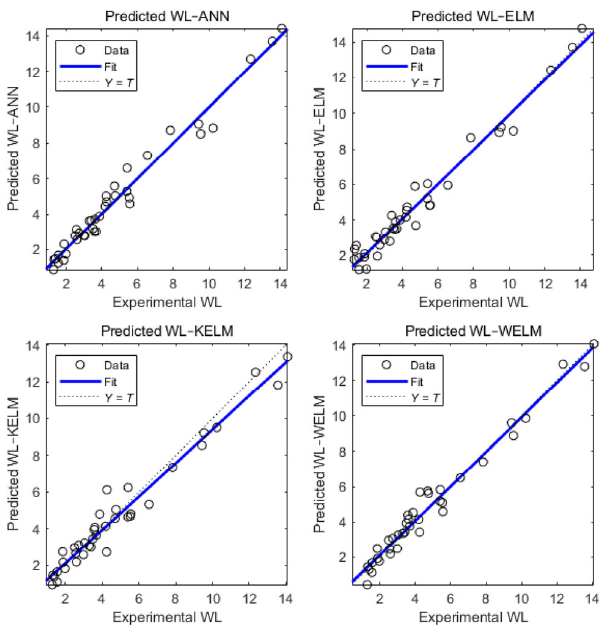
Fig. 8 Scatterplots of the ANN, ELM, KELM, and WELM models.